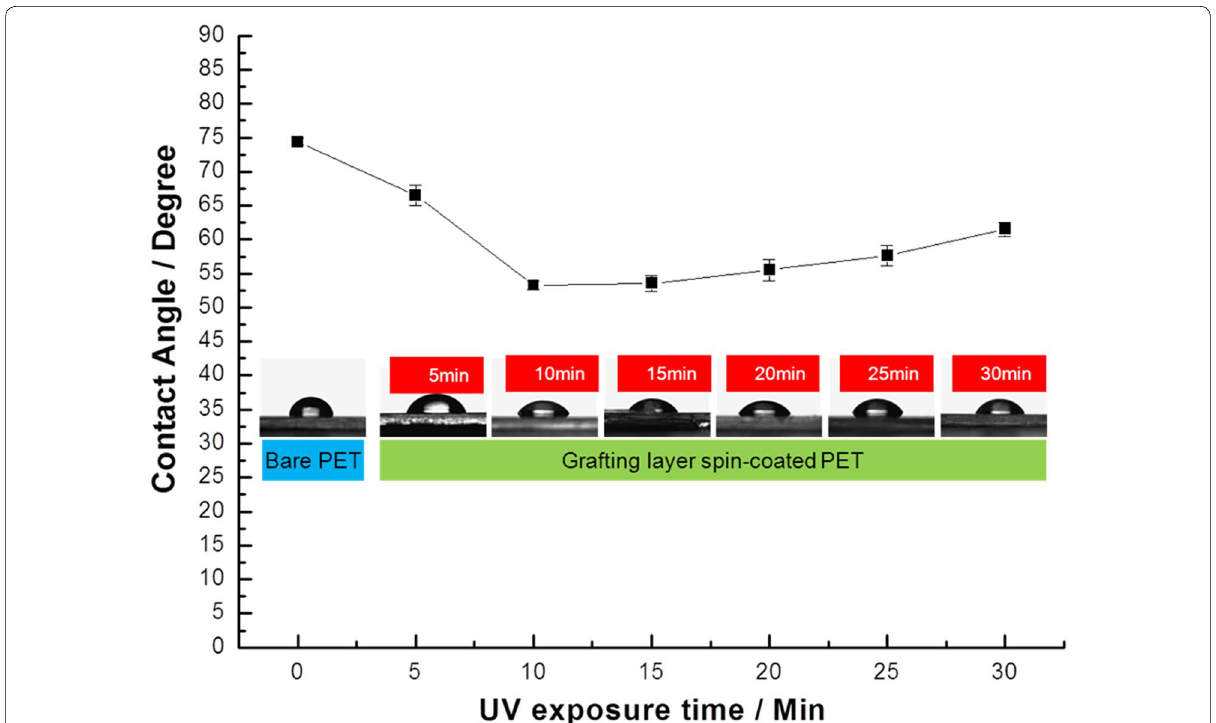
Fig. 2 The contact angle measurement of the grafting layer on PET